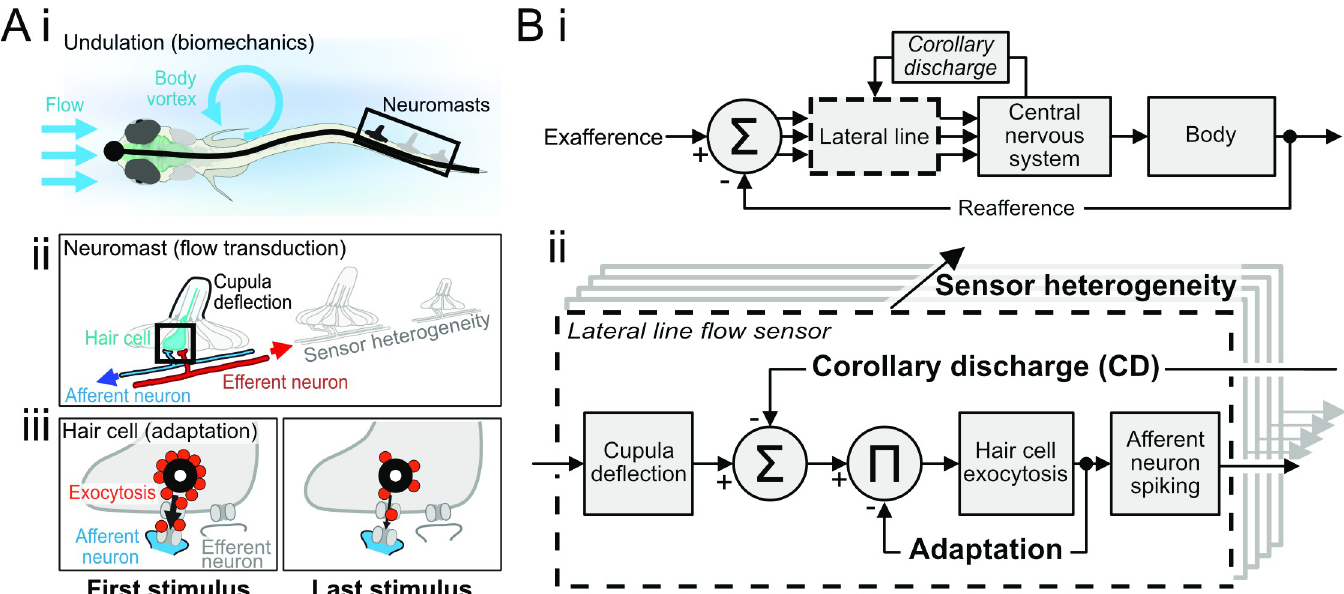
Fig 1. A systematic approach for cellular-to-organismal integration in swimming fish. (A) (i) Fish sense water flows that originate in the environment (exafference) or are self-induced by undulatory locomotor mechanics (reafference). Both sources generate alternating currents across a wide band of frequencies, which are transduced by neuromasts along the body length. (ii) Afferent neuron signaling of neuromast deflections is mediated by receptor potentials in hair cells, as modulated by inhibitory efferent neuron activity. (iii) Depolarization of hair cells results in vesicle exocytosis onto postsynaptic afferent neuron boutons. Sustained neuromast deflection results in adaptation, here depicted as synaptic depression. (B) Hypothetical architecture of closed-loop motor control in fishes. (i) Many individual sensors in the lateral line transduce the summed exafferent and reafferent inputs. Each sensor transmits a filtered signal to the central nervous system. Brain computations extract key flow features that guide motor actions. Motor signals drive behavior, and motor signal copies called CD modulate lateral line feedback in anticipation of self-induced feedback from those behaviors. (ii) Elaboration of the sensor block to understand the effects of CD modulation on lateral line feedback. Cupula deflection drives vesicle exocytosis from hair cells, which leads to synaptic depression and adaptation of afferent neuron spike rates. Inhibition by CD reduces exocytosis and therefore afferent spike rates, but also prevents adaptation. This is replicated throughout the lateral line, so the interactions between adaptation, CD, and sensor heterogeneity are central to understanding the nature of feedback during swim bouts. C AU : AbbreviationlistshavebeencompiledforthoseusedthroughoutFigs 1 (cid:0) 7 : Pleaseverifythatallentriesarecorrect : D, corollary discharge.